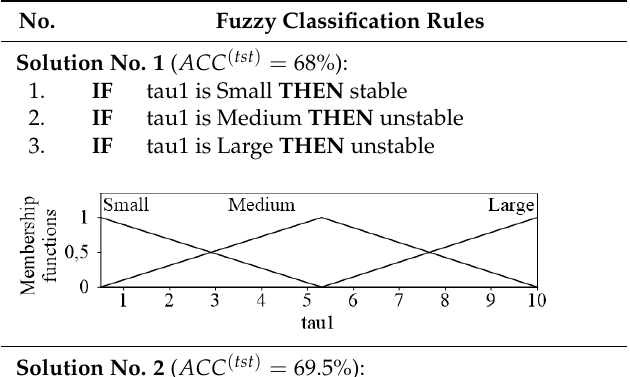
Table 3. Fuzzy rule bases for SPEA3-based solutions (FRBCs) 1–3 from Figure 4. No. Fuzzy Classification